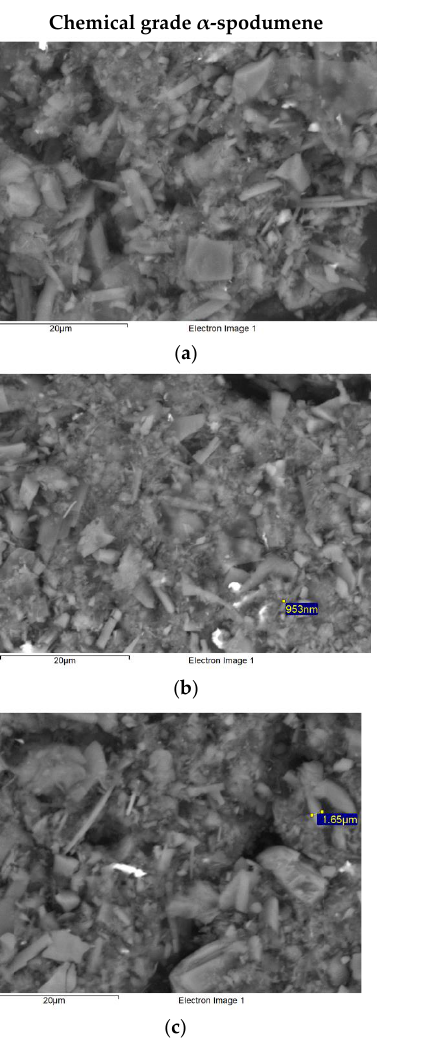
Figure 1. ( a ) XRD spectra of minerology of crystalline particles in chemical grade α -spodumene concentrate test sample, ( b ) XRD spectra of minerology of crystalline particles in technical grade α - spodumene concentrate test sample.